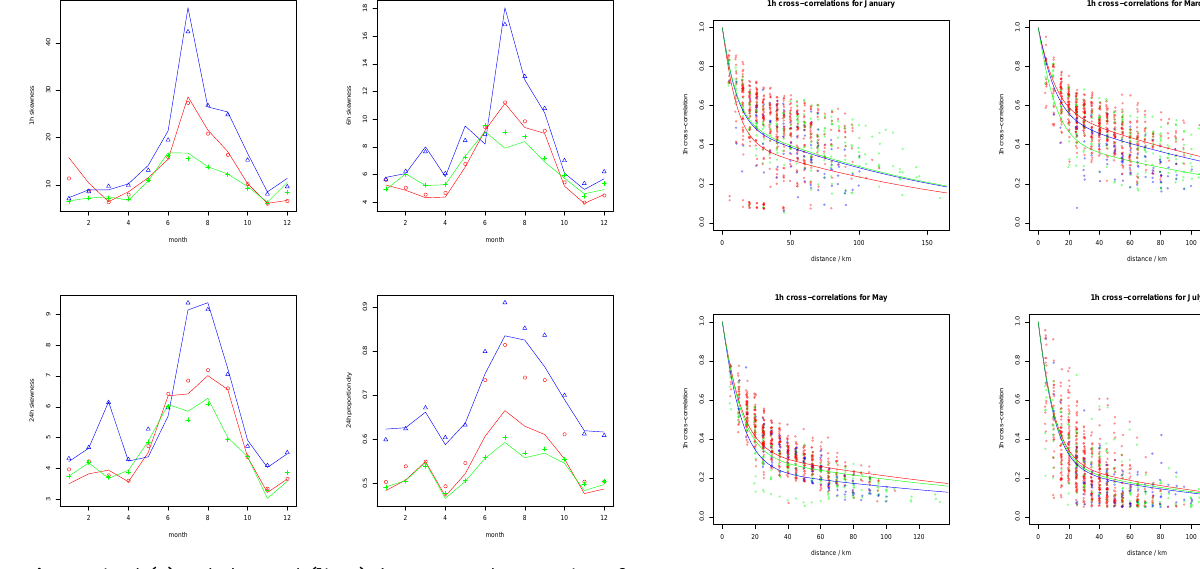
Fig. 7. Median annual maxima of sites in the central region. The observed (-) consists of three samples of 20 years. The simulated (blue circles) are based on 50 samples of 20 years (1000 years of simulated data).